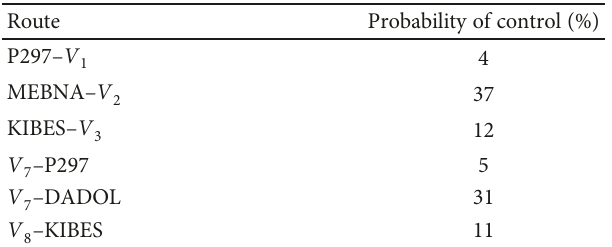
Table 2: Distribution of control preference for each route of the sector 02.